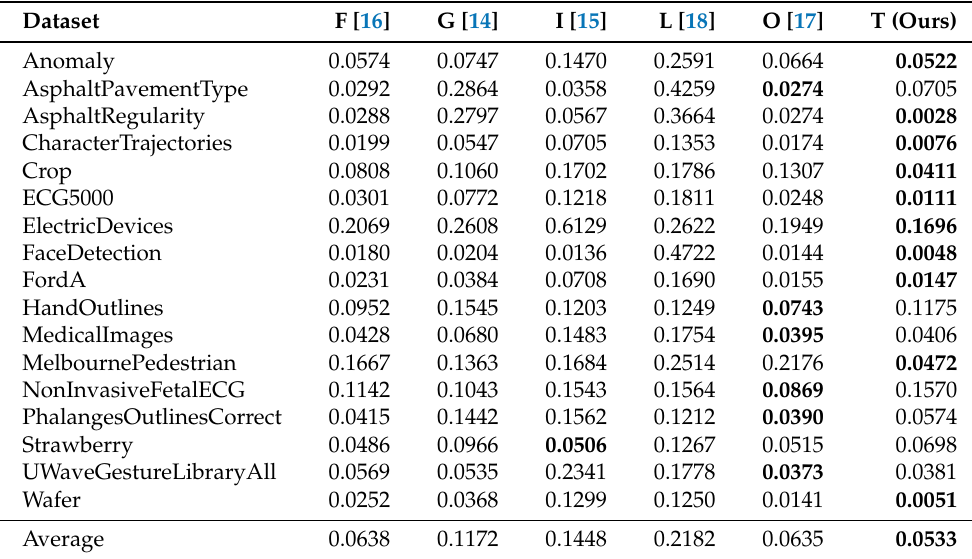
Table 5. Sensitivity. Lower values correspond to better performance. The method names are shortened by taking only the initial character (FeatureAblation, Guided-Backpropagation, Integrated- Gradients, LIME, Occlusion, TimeREISE). Perturbation-based approaches show superior performance. TimeREISE shows the best performance across most of the datasets. Best results are highlighted in